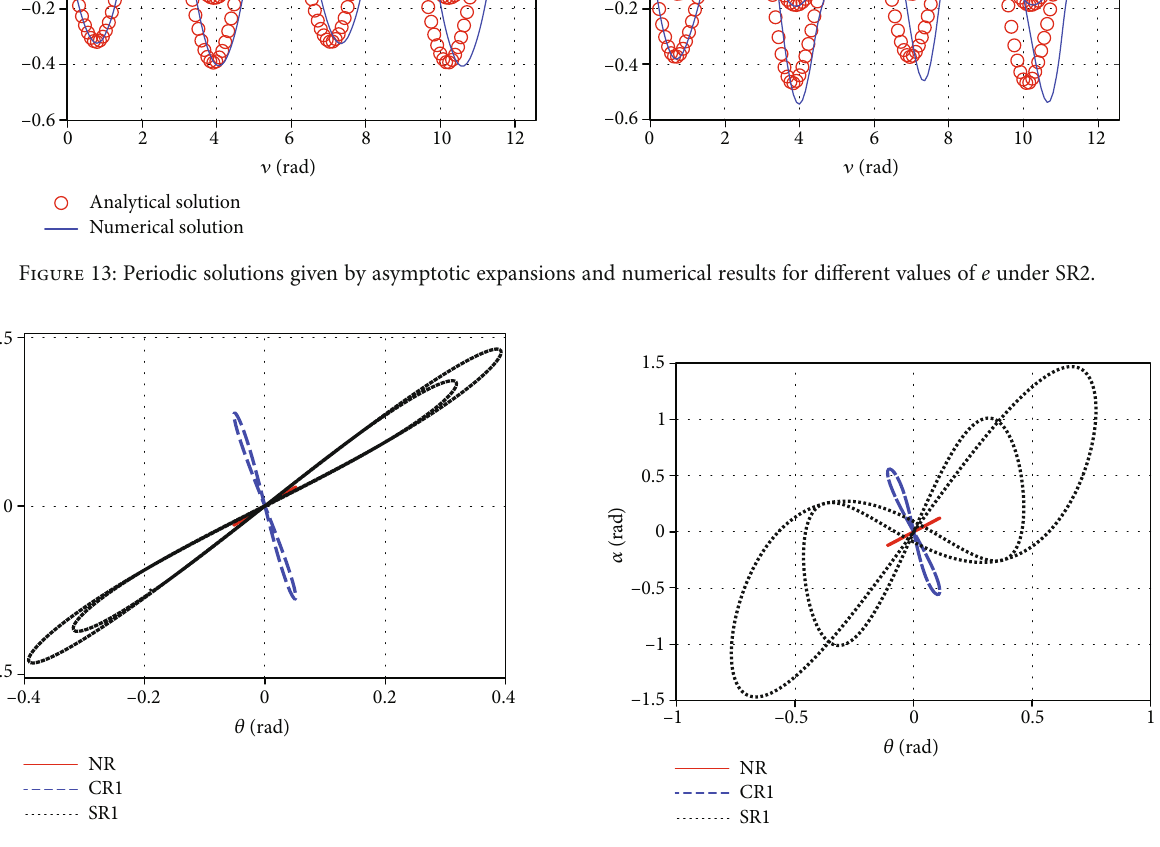
Figure 15: The phase diagram of basic periodic solutions in e = 0 : 1 under NR, CR1, and